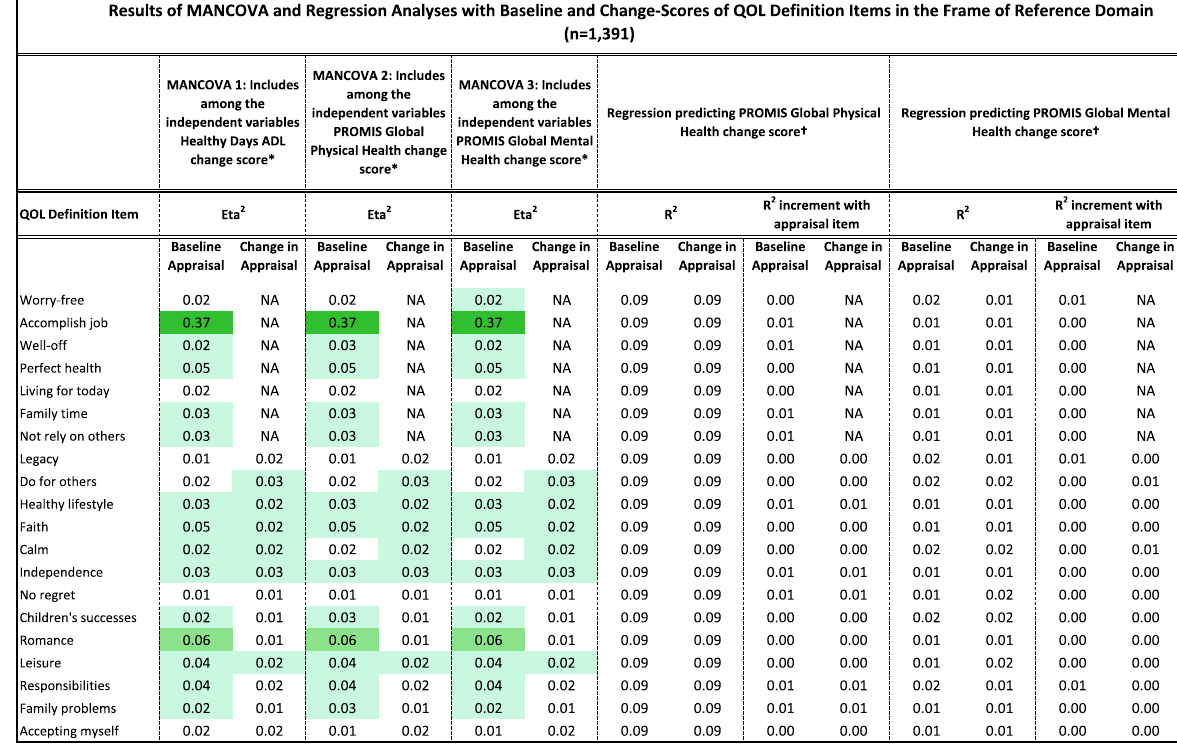
Table 2 Results of MANCOVA and Regression Analyses with Baseline and Change-Scores of QOL Definition Items in the Frame of Reference Domain ( n =